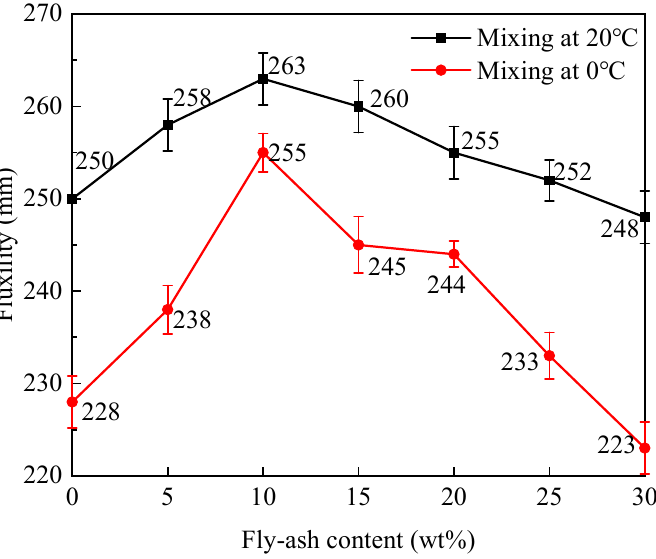
Figure 3 . The variation of fluidity with mixing temperature and fly ash content . Figure 3. The variation of fluidity with mixing temperature and fly ash